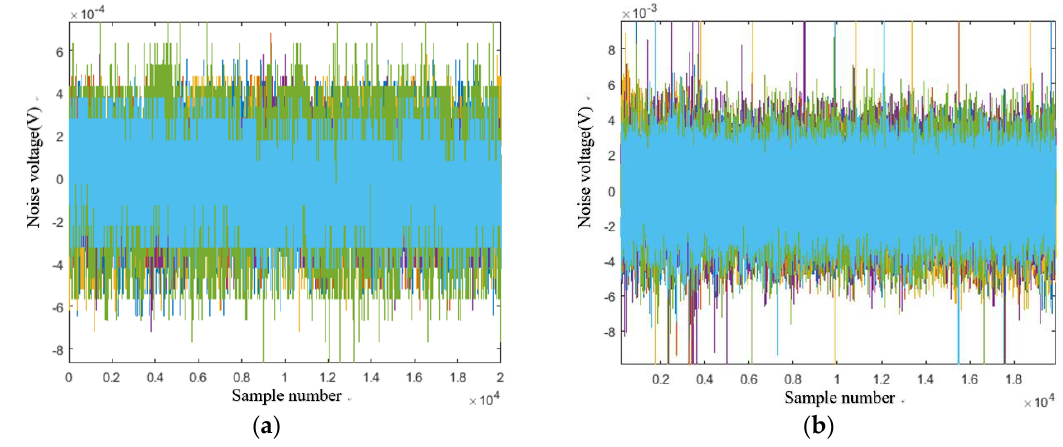
Figure 10. Inherent noise of the Hall sensor and the laser sensor: ( a ) inherent noise of the Hall sensor; ( b ) inherent noise of the laser sensor.